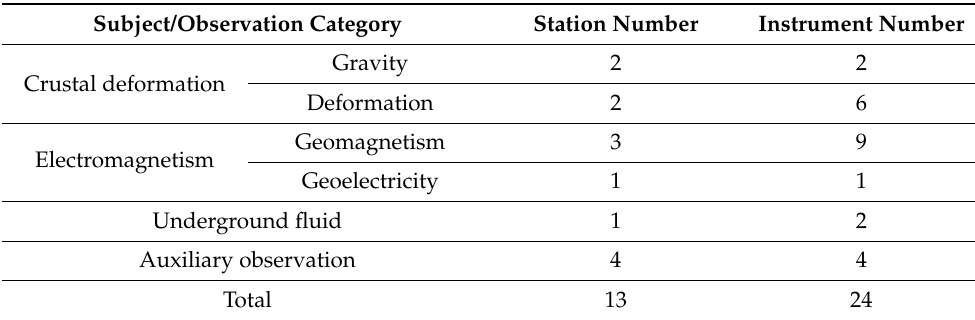
Table 1. Statistical table of stations/instruments composing the Tibetan Regional Seismic and Geophysical Network.